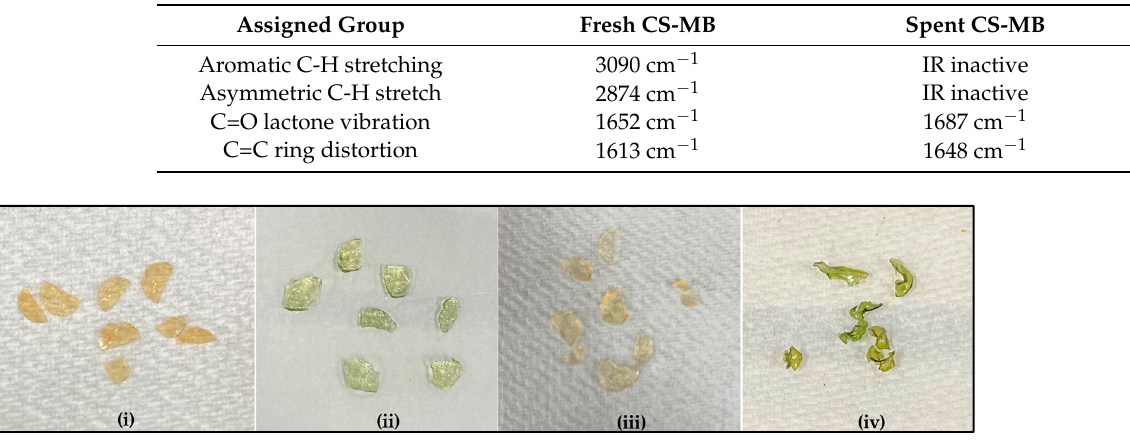
Figure 9. Fresh and Cu 2+ uptake spent hydrogels in their dry and swollen states: ( i ) fresh dry CS-MB; ( ii ) Cu 2+ uptake spent swollen CS-MB; ( iii ) fresh swollen CS-MB; ( iv ) Cu 2+ uptake spent dry CS-MB.